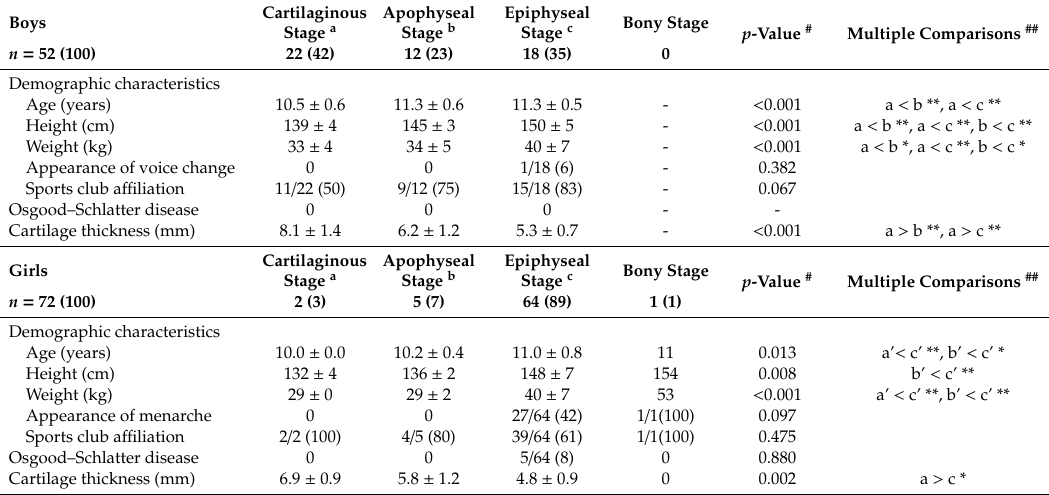
Table 2. Proportion of subjects (124 grade 5–6 elementary schoolchildren) in tibial tuberosity maturity stages, as well as demographic characteristics, frequency of Osgood–Schlatter disease, and cartilage thickness at the tibial tuberosity of subjects in each maturity stage by sex.